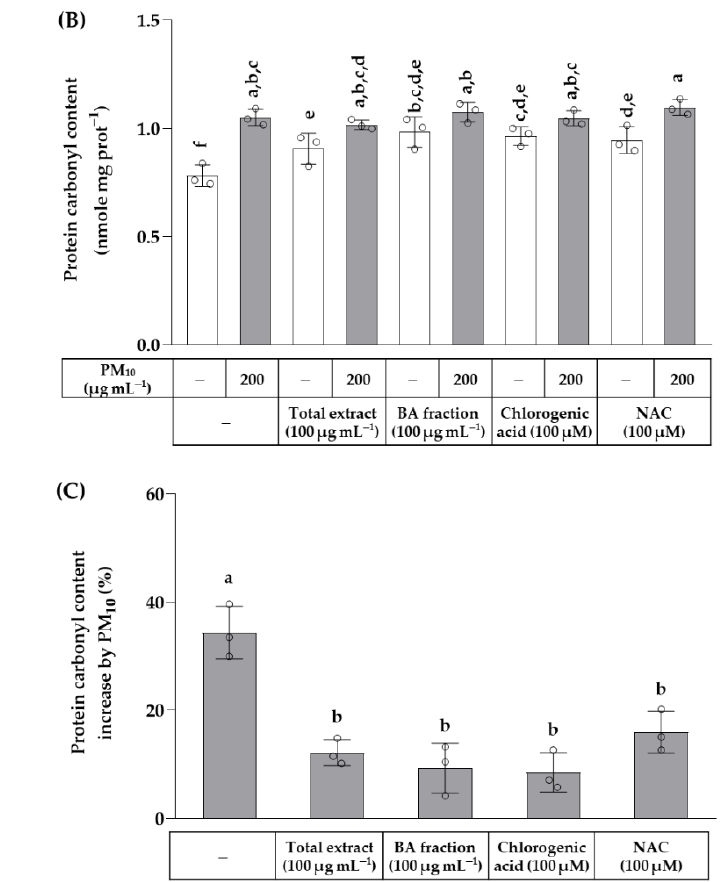
Figure 6. Effects of the total OJ extract, its BA fraction, chlorogenic acid, and NAC on the protein carbonyl content in HaCaT keratinocytes exposed to PM 10 . In ( A ), cells were treated with different concentrations of PM 10 . In ( B , C ), cells were treated with the total OJ extract (100 µ g mL − 1 ), BA fraction (100 µ g mL − 1 ), chlorogenic acid (100 µ M), and NAC (100 µ M), alone or in combination with PM 10 (200 µ g mL − 1 ), for 48 h. Protein carbonyl contents were normalized to the protein contents and presented in nmole mg protein − 1 ( B ) . The % change in the protein carbonyl contents due to PM 10 exposure in each group was calculated using the following equation: change (%) = ( α − M)/M × 100, where α is the value in the presence of PM 10 and M is the mean value of each group in the absence of PM 10 ( C ). Data are presented as mean ± SD ( n = 3). Groups that do not share the same lowercase alphabet letters (a–f) are considered to have significantly different means at the p < 0.05 level.